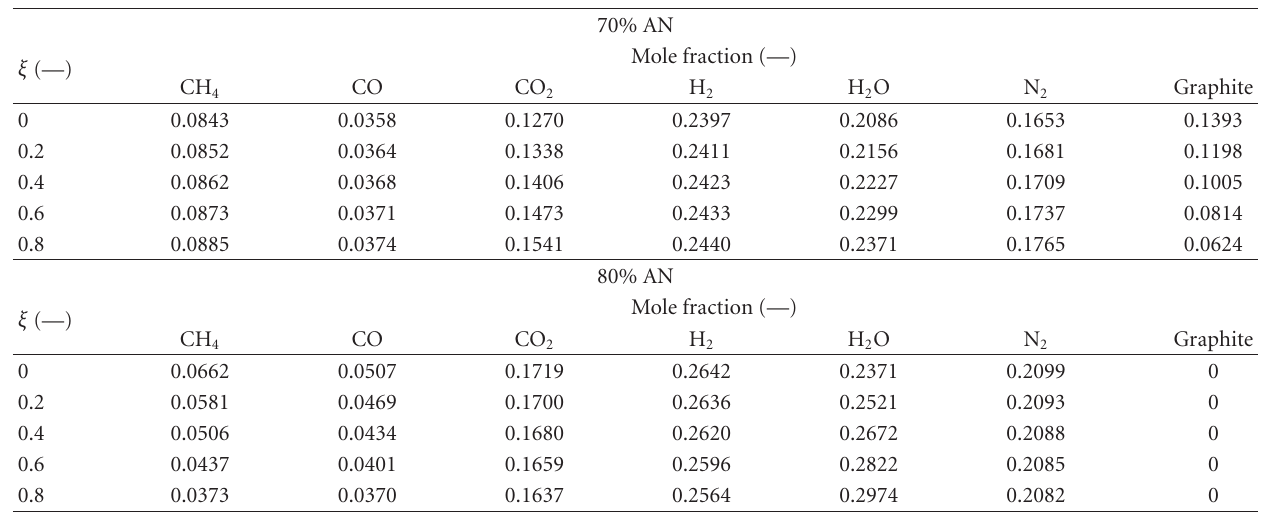
Table 4: Theoretical mole fraction of main combustion products of AN/HTPB/PTHF2